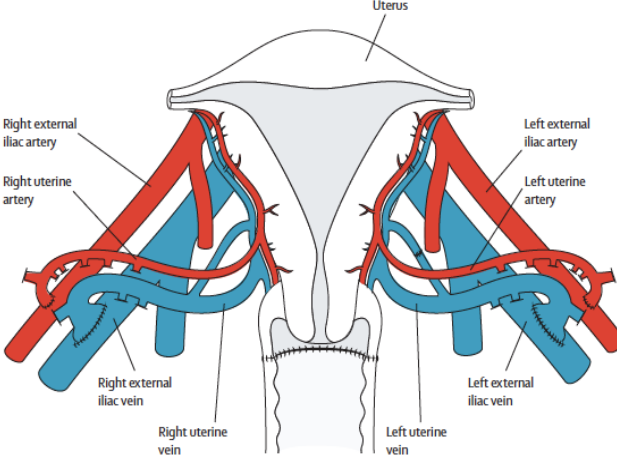
Figure 5: Schematic representation of the major steps of UTx. (Reproduced from Brännström et al.